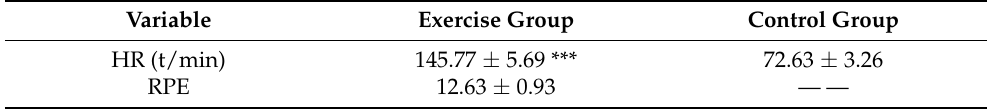
Table 2. Exercise intensity evaluation of subjects.